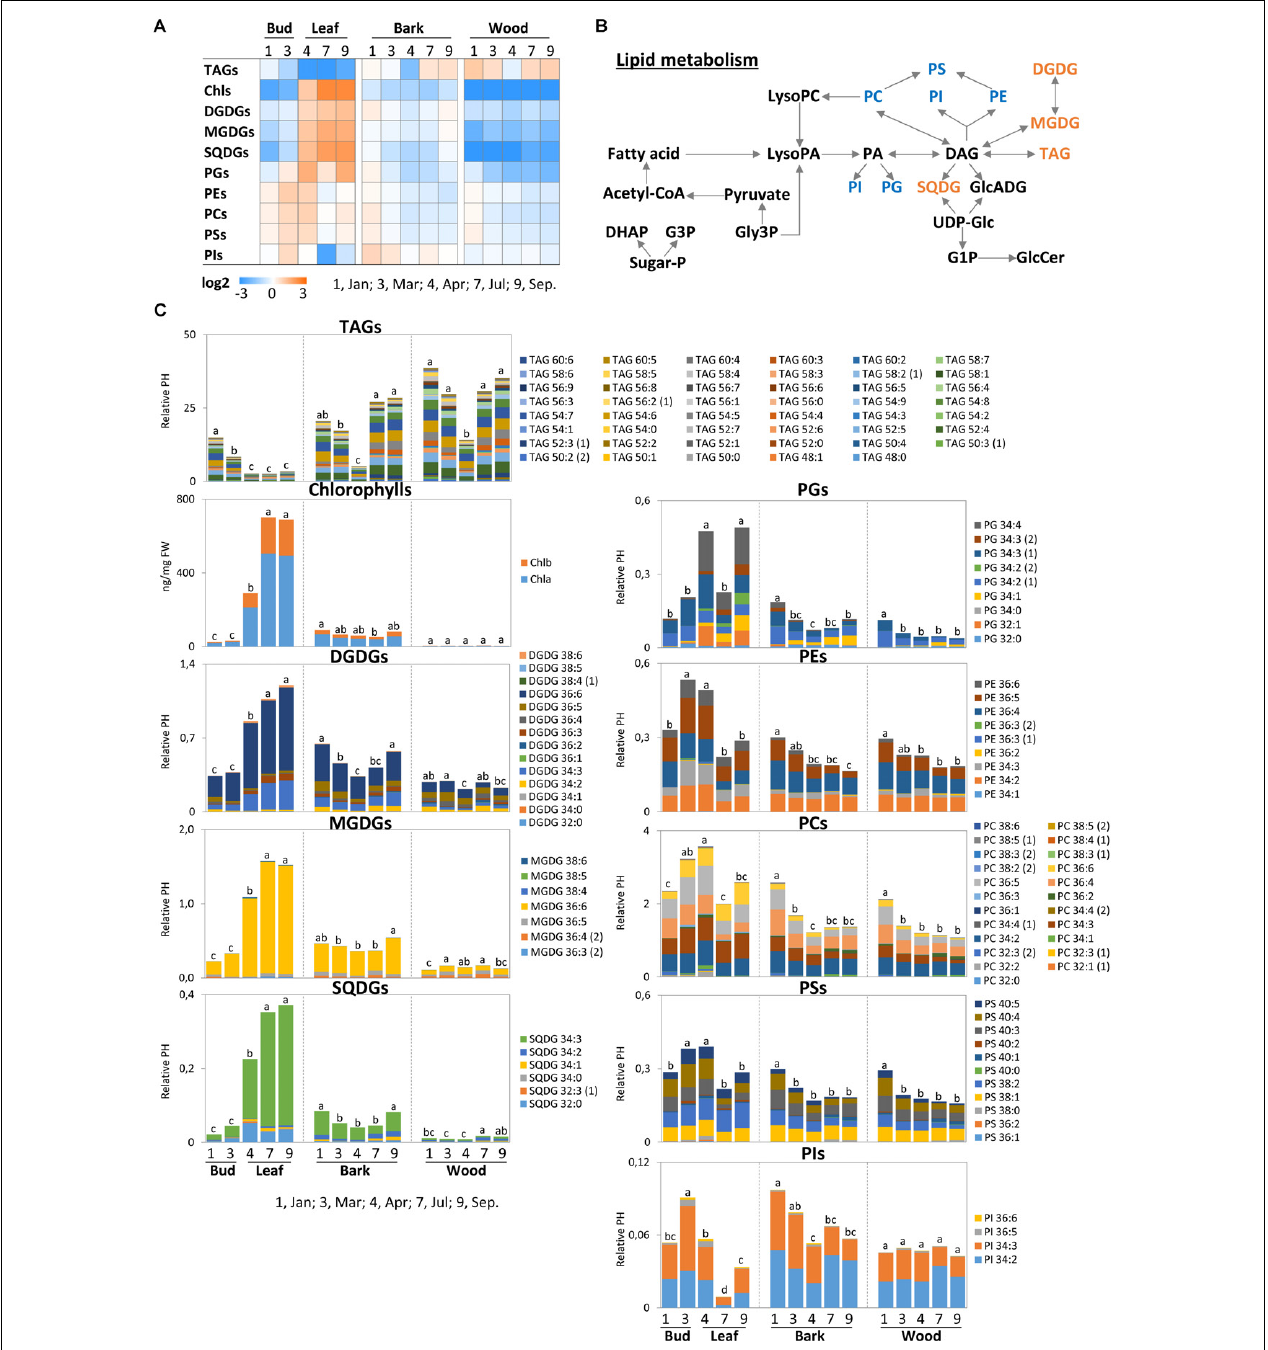
FIGURE 8 | Metabolic changes in lipid metabolism. Changes of the selected metabolites in lipid metabolism in poplar twigs during annual growth. (A) Changes of total lipid in each class. (B) Lipid metabolic pathway according to Gardocki et al. (2005); Boudière et al. (2014), Guschina et al. (2014); Kobayashi (2016), and Xue et al. (2017). (C) Changes of individual lipid molecular species in each class. Log2 ratios of fold changes from the average value of all organs/tissues and seasons are given by shades of red or blue colors according to the scale bar. Data represent mean values of five biological replicates in each organ/tissue for each seasons. Different letters represent statistically significant differences ( P < 0.05) between seasons in each organ/tissue with the total lipid values in each class using Tukey’s test. Statistical analysis of individual lipid species was performed using Tukey’s test ( Supplementary Table S2 ). Relative PH, relative peak height; DHAP, dihydroxyacetonephosphate; Sugar-P, sugar-phosphate; G3P, glucose-3-phosphate; Gly3P, glycerol-3-phosphate; LysoPC, lysophosphatidylcholine; LysoPA, lysophosphatidicacid; GlcADG, glucoronosyldiacylglycerol; UDP-Glc, uridine-diphosphate-glucose; G1P, glucose-1-phosphate; GlcCer, glucosylceramides; TAGs, triacylglycerides; Chls, chlorophylls; MGDGs, monogalactosyldiacylglycerols; DGDGs, digalactosyldiacylglycerols; SQDGs, sulfoquinovosyldiacylglycerols; PGs, phosphatidylglycerols; PEs, phosphatidylethanolamines; PCs, phosphatidylcholines; PSs, phosphatidylserine; PIs, phosphatidylinositols; DAGs, diacylglycerols.